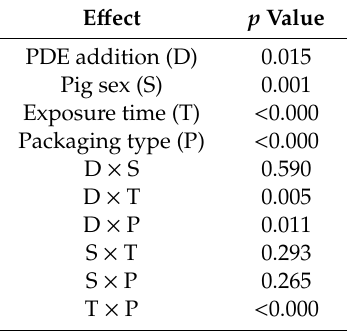
Table 2. Values of p for studied effects (plant extract addition, pig sex, exposure time and packaging type) on consumer visual appraisal scores of pork